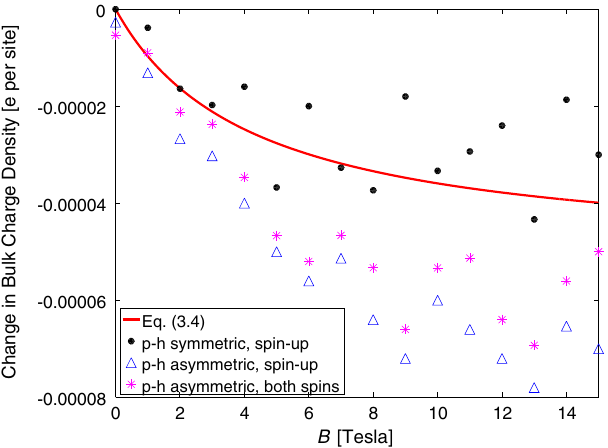
FIG. 5. Numerically calculated change in the bulk charge density δρ bulk in response to unidirectional strain α ¼ 0 . 03 as a function of the applied field B . Parameters for Cd 3 As 2 are used with μ ¼ 0 and d ¼ 1000 Å (50 lattice sites). Solid black symbols give result for the p-h symmetric version of the 1 -Cd 3 As 2 model obtained by setting all C parameters to zero. 2 j Landau level. The corresponding results that are valid away from the quantum limit are given in Appendix B.